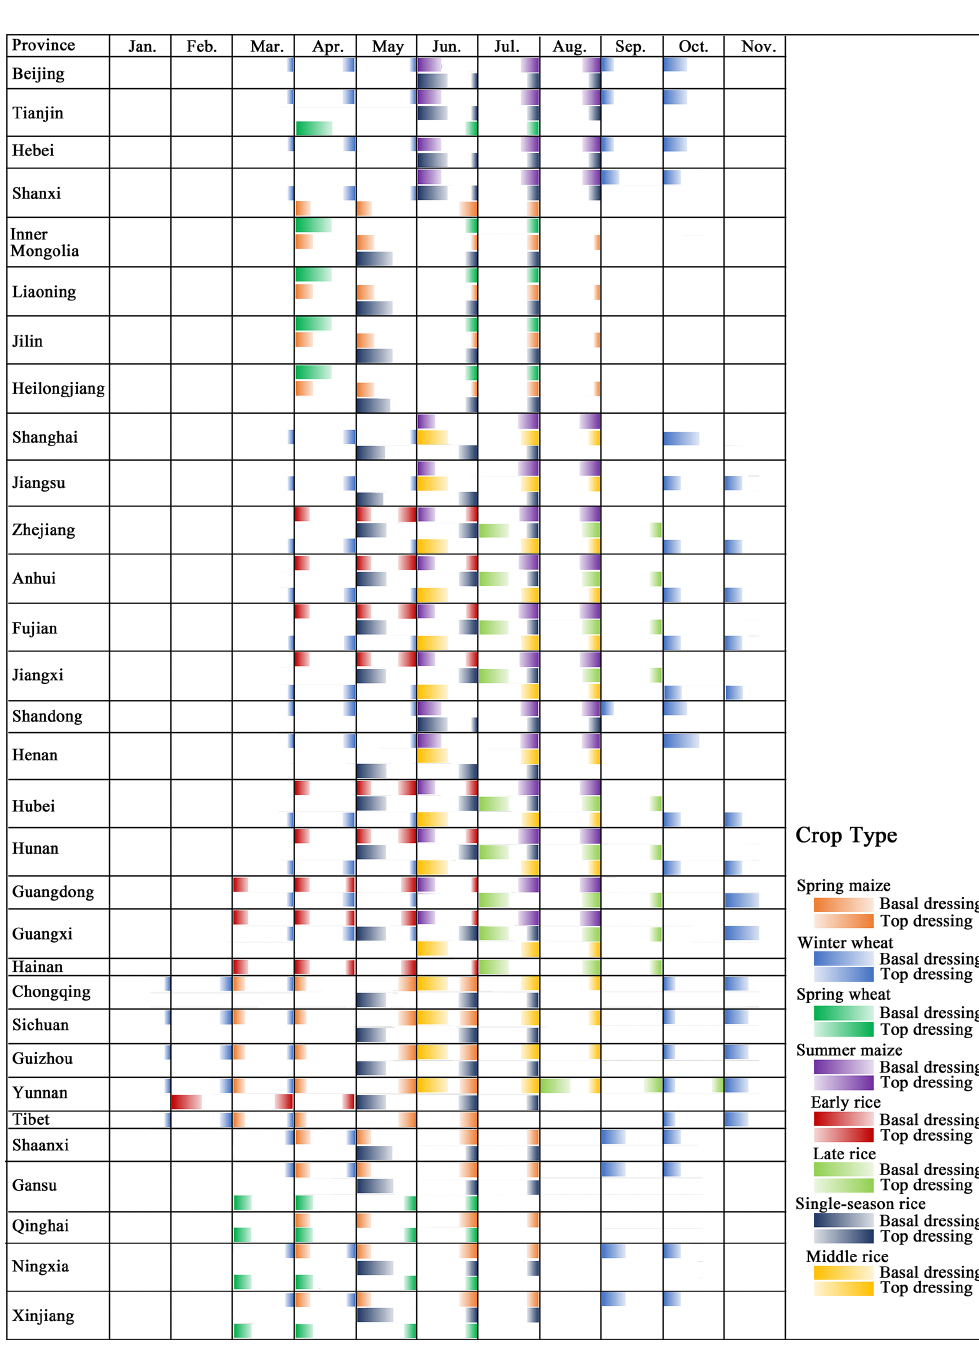
Figure 1. Basal and top dressing fertilization months and ratios for maize, wheat, and rice in